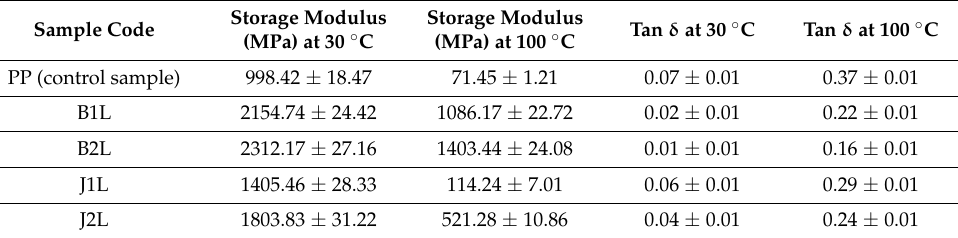
Figure 4. ( a – d ) Optical images of the fractured samples and ( e – h ) the SEM images of the cross-section. Table 5. The results of the DMA